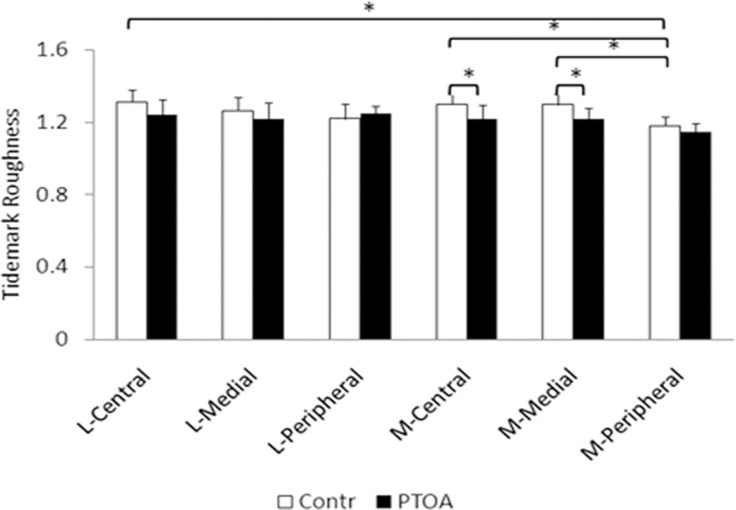
The tidemark roughness at the six selected locations on the tibial plateau of the PTOA and control knees.The tidemark roughness in the control knees varies from area to area on the tibial plateau. In the PTOA knees, there are not regional differences in tidemark roughness. In addition, the generally reduced tidemark roughness in the PTOA knees is statistically significant at the central and medial areas of medial plateau, when compared with the controls. Note: * indicates p < 0.05. L = lateral plateau; M = medial plateau.